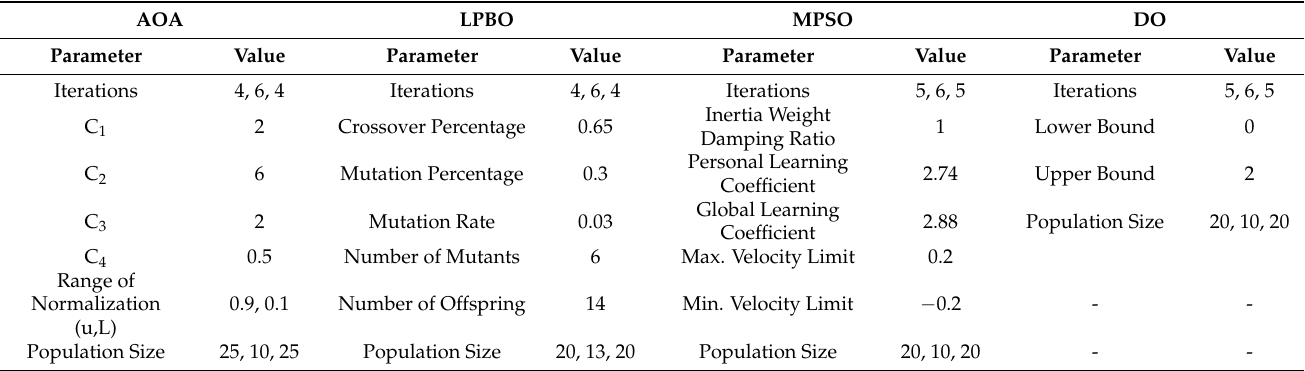
Table 3. Parameters of optimization algorithms.